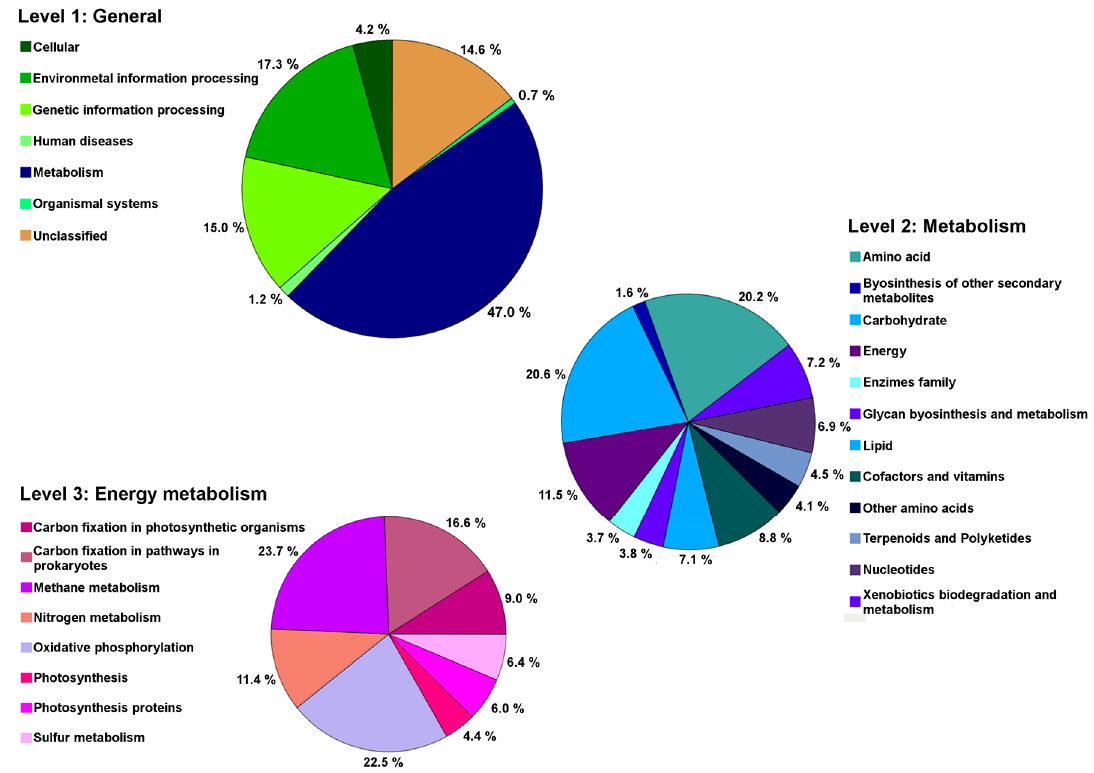
Figure 8. Predicted metabolic functions of Methylobacterium , the dominant member of the seed endophyte core microbiome of Crotalaria pumila across three generations.